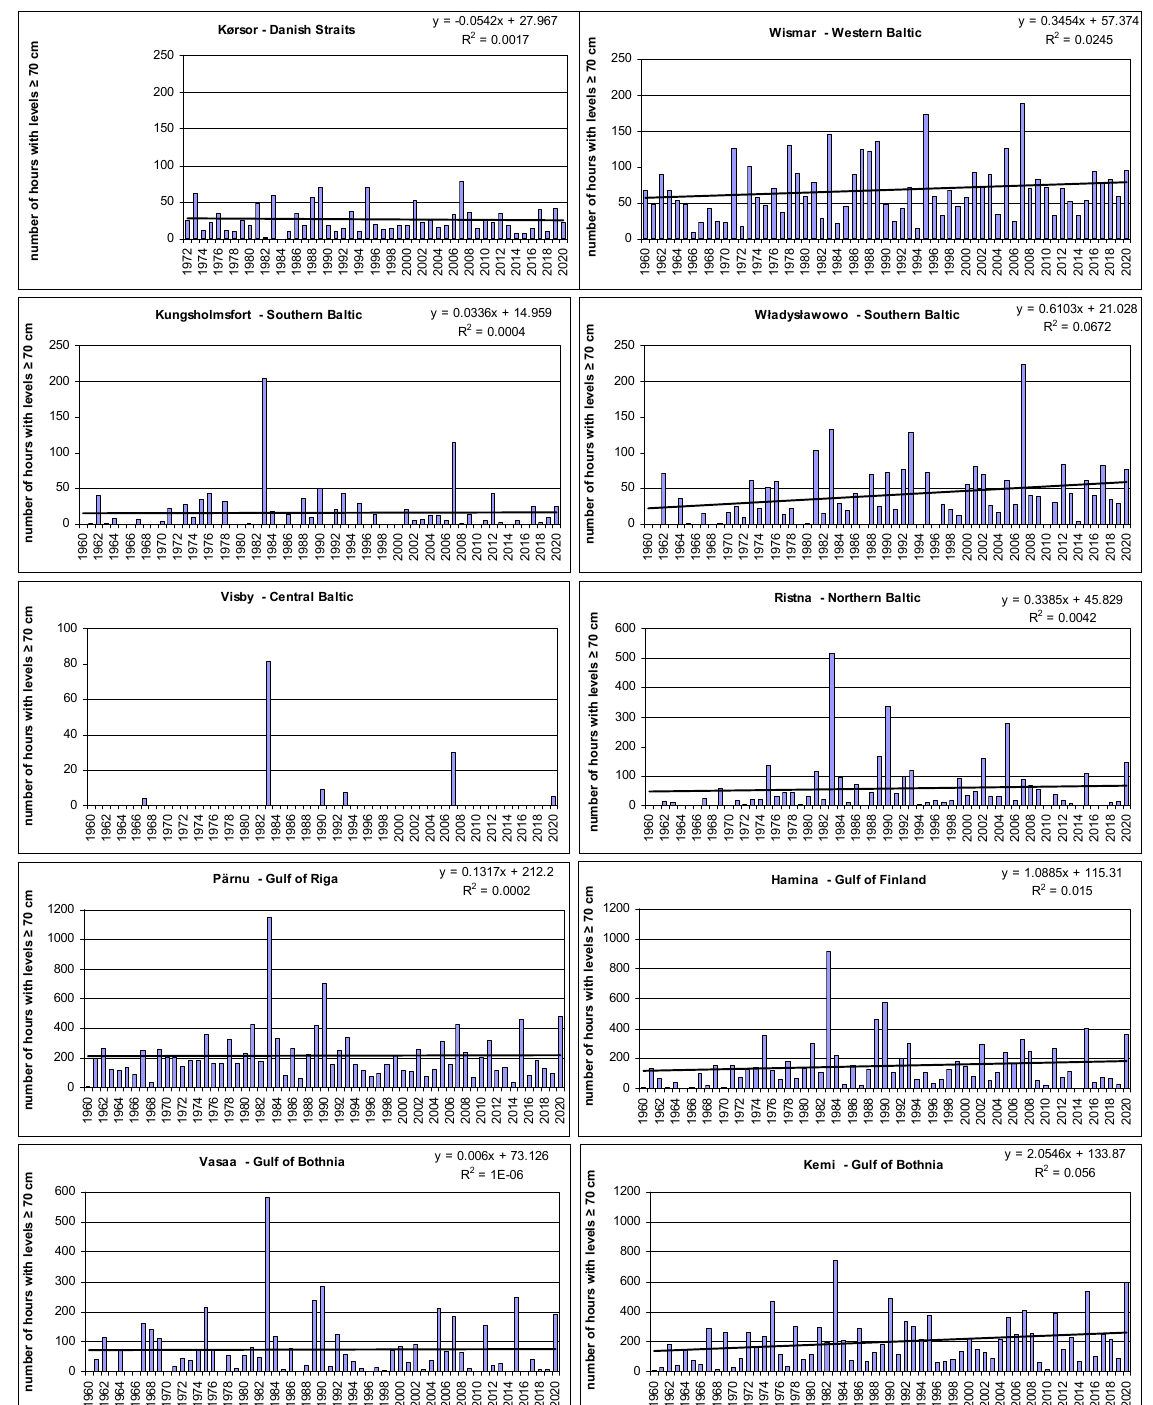
Figure 10. Duration of high sea levels ( ≥ 70 cm relative to zero of tide gauge) at selected tide gauges and their trends through the study period 1960–2020. The year 1982 stands out as the period characterized by the longest duration (i.e., the highest number of hours) of high sea levels in a multi-year perspective. (Legends: blue columns —number of hours of high sea levels).